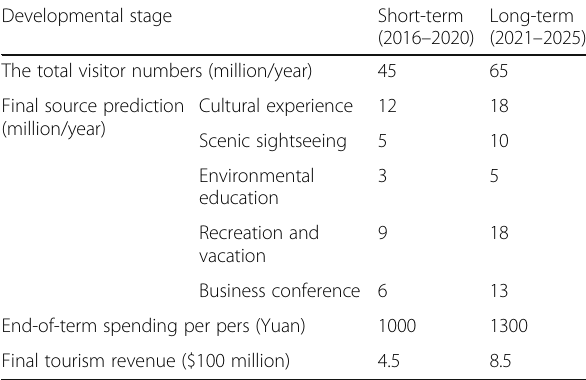
Table 2 Visitor volume